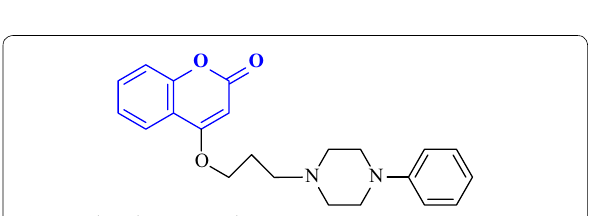
Fig. 10 Phenylpiperazine derivative C8